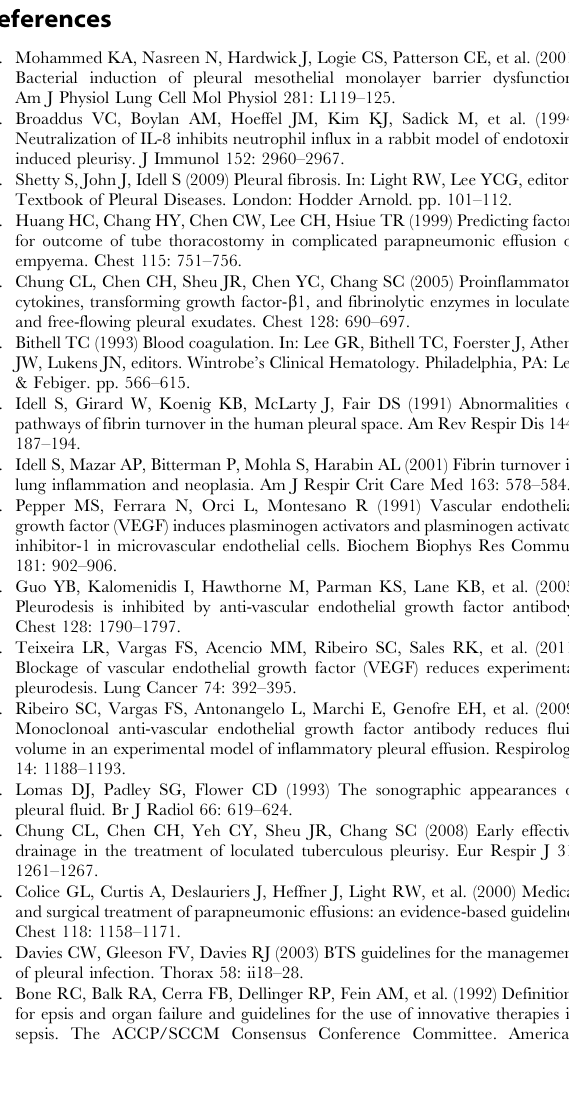
Table S1 Demographic and Clinical Data of the Pa- tients Studied. Table S2 Comparisons of the Data on Discharge and at 6-month Follow-up* between the Patients with UPPE and CPPE. Protocol S1 Criteria and validation for loculated and non-loculated effusions.